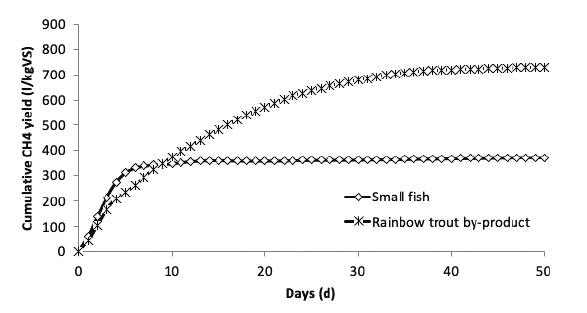
Figure 2: 50-day cumulative CH materials